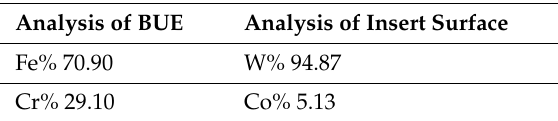
Figure 6. ( a ) SEM image of BUE region; ( b ) Energy-dispersive X-ray spectroscopy (EDS) spectrum analysis of the BUE zone on the rake face; ( c ) EDS spectrum analysis of the tool surface; and ( d ) color map of the Fe and Cr elements on the BUE region. Table 3. EDS analysis of surface on the tool.